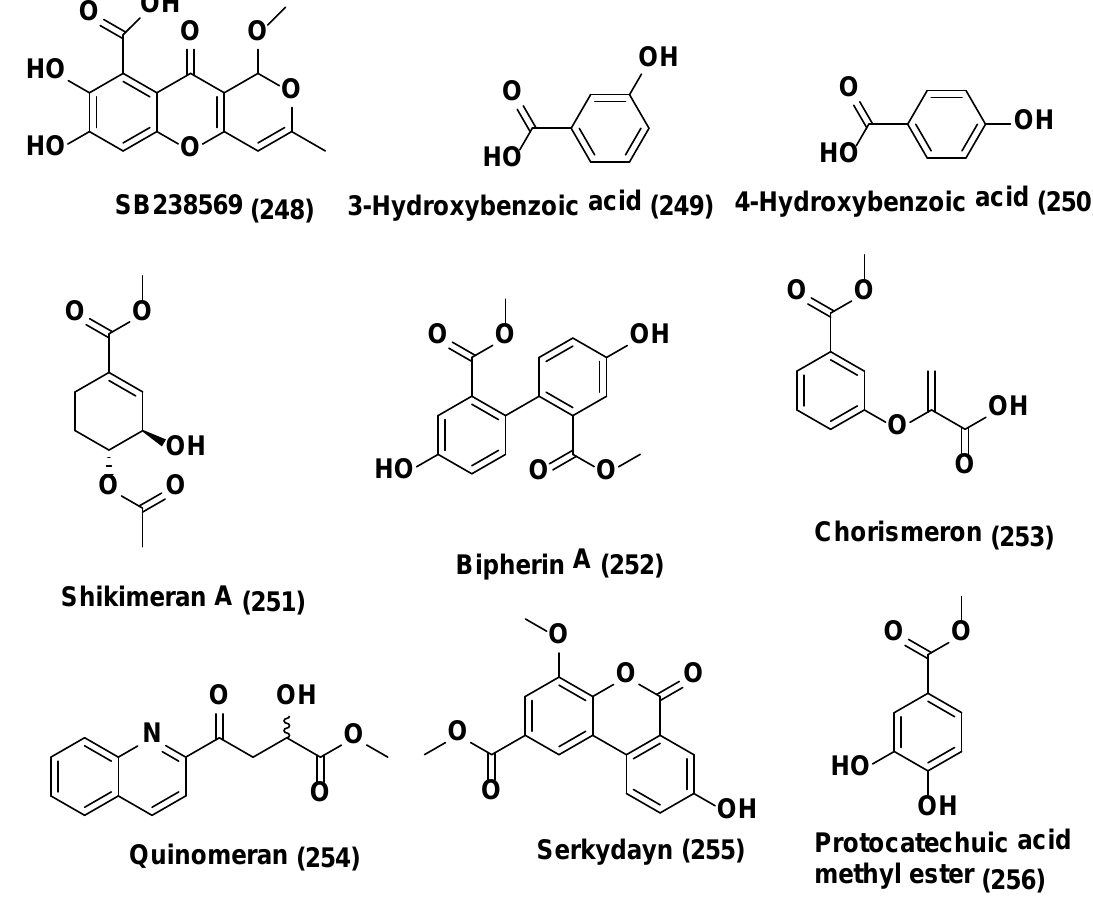
Figure 13. Structures of metabolites obtained from co-culture in endophytic fungi ( 248 – 256 ).